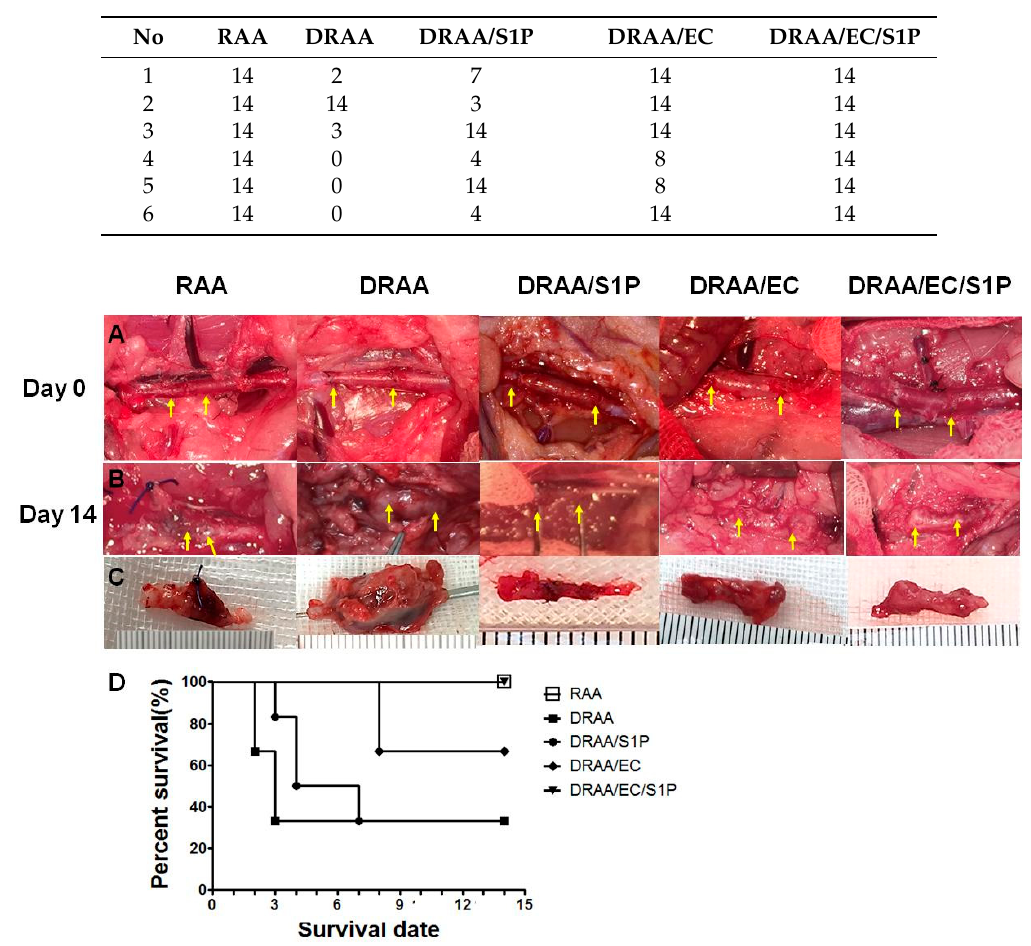
Table 1. The survival date of animals after surgery (days).